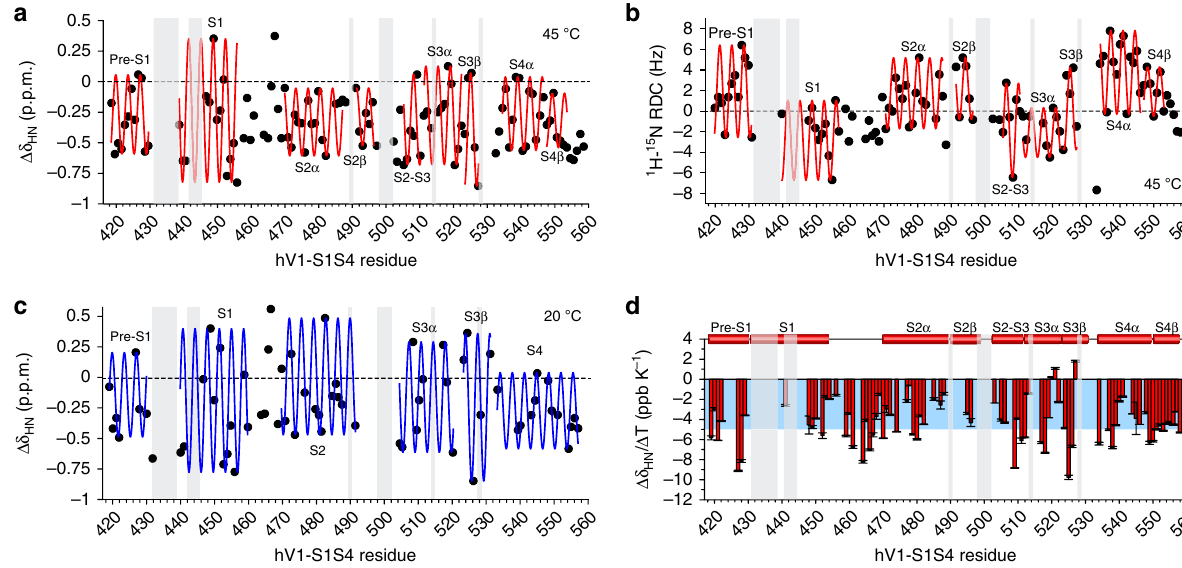
Fig. 3 hV1-S1S4 undergoes subtle temperature-induced changes in secondary structure. a Amide proton Δδ analysis identi fi es hV1-S1S4 secondary structure at elevated temperature (45 °C). b Dipolar wave analysis from RDC measurements of the hV1-S1S4 at 45 °C independently identi fi es secondary structure. c Amide proton Δδ analysis at 20 °C identi fi es that the hV1-S1S4 secondary structure is distinct from that at elevated temperature and generally consistent with cryo-EM secondary structures. In panels a – c , black circles are individual data points and are superimposed with fi ts of the data to an α - helical periodicity (red or blue lines respectively). d A bar plot of the amide proton temperature coef fi cients ( Δδ HN / Δ T ) against the hV1-S1S4 residue number. Values greater than − 4.6 ppb K − 1 are indicative of hydrogen bonding and are highlighted (blue). Light gray boxes indicate regions where NMR resonances are unassigned at 45 °C. Δδ HN / Δ T errors bars arise from fi tting uncertainty. Source data are provided as a Source Data fi